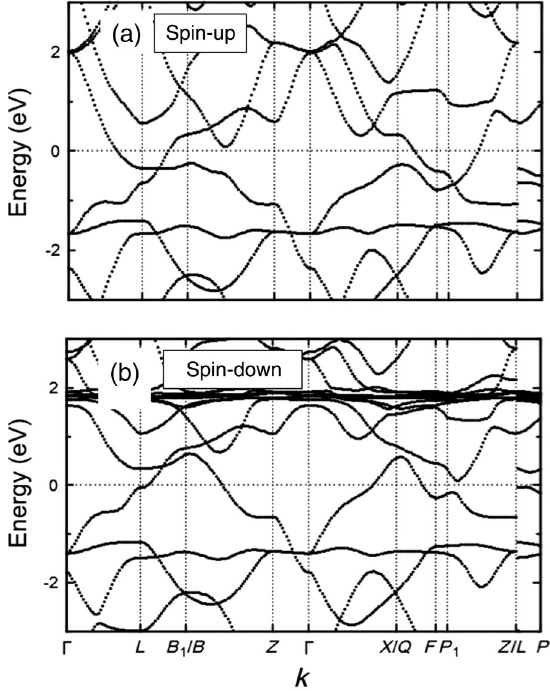
13. Calculated band structure of Ho 2 C.